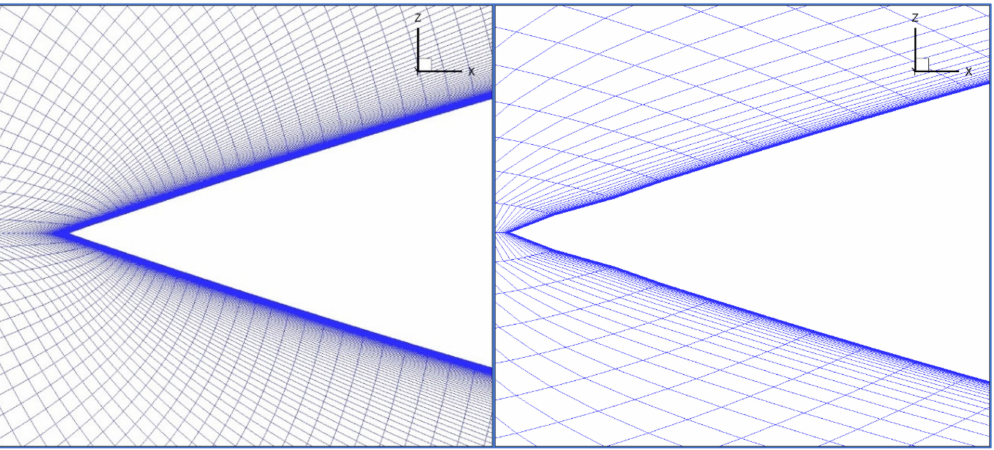
Figure 1. Detail of two structured grids in the nose tip. ( Left ) finer grid. ( Right ) coarser grid. A detail of the structured grid (Grid S1) is shown in Figure 2. A stretching law is applied in normal direction. The height of the first cell to the surface was chosen as 10 − 5 m. With this value, the y + was of order 1.